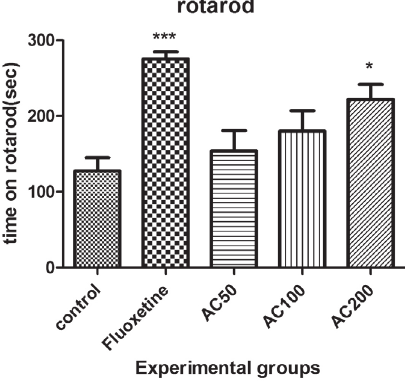
FIGURE 3 - Effect of Adiantum capillus-veneris extract on motor activity in Plus Maze. *** = ( P < 0.001); * = ( P < 0.05); AC: Adiantum